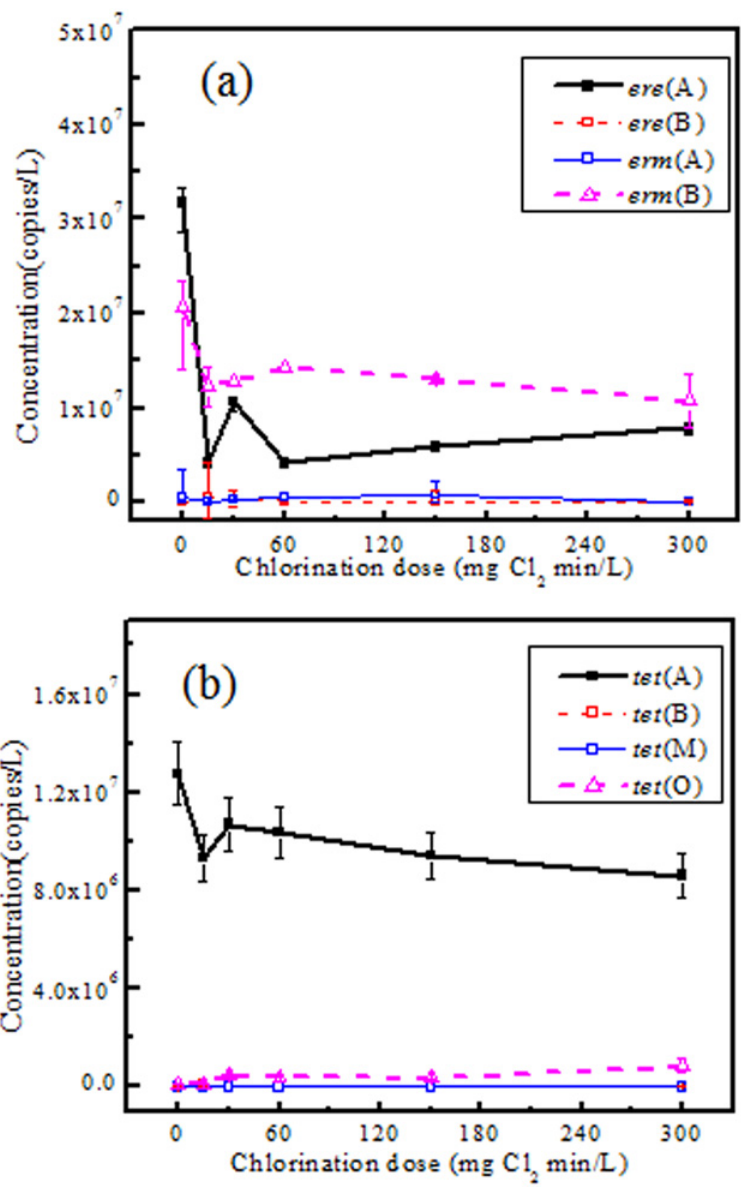
Fig 3. Abundance of four ERY resistance genes (a) and four TC resistance genes (b) in samples treated by chlorination under a series of doses (mg Cl 2 min/L). Error bars indicate standard deviation for replicates from a single